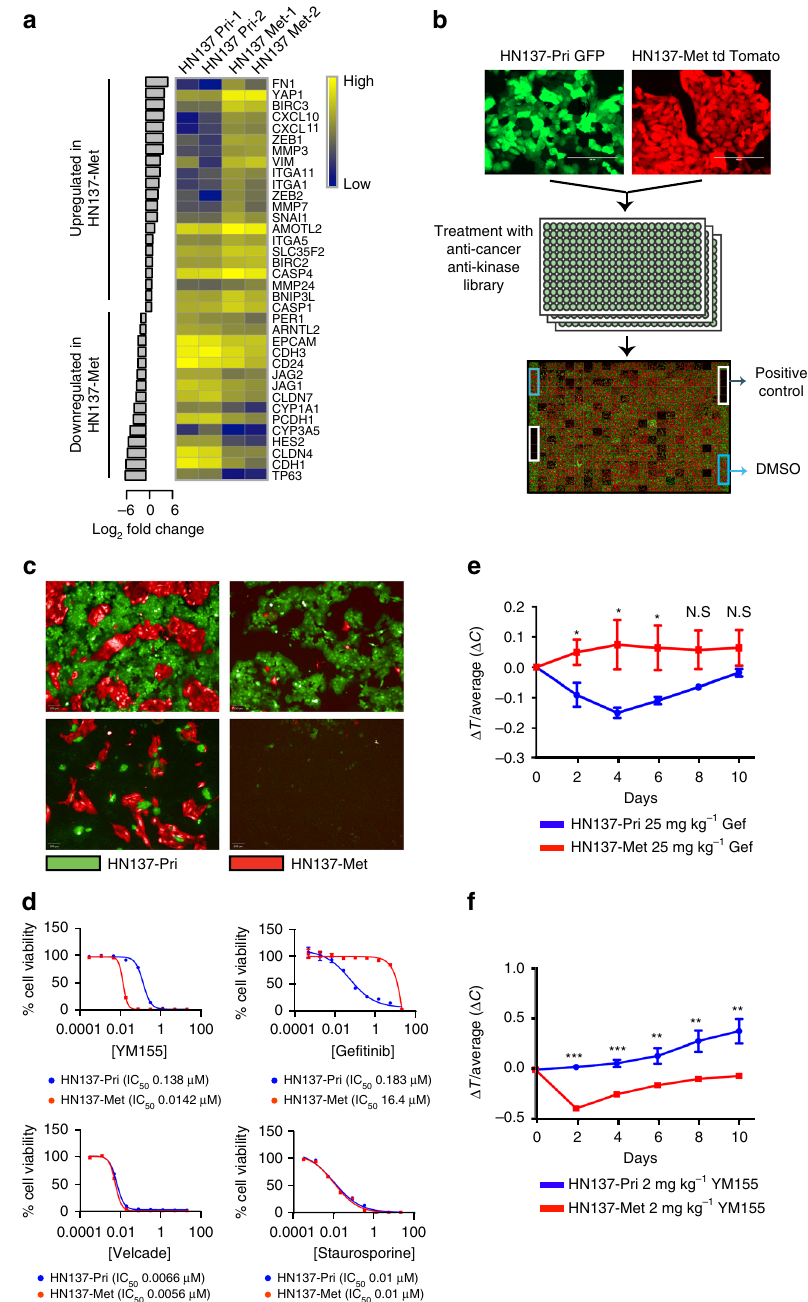
Fig. 2 Small molecule screen against HN137 PDC revealed patient-speci fi c therapeutic vulnerabilities validates in vivo. a Differentially expressed genes (fold-change > 2) in HN137-Met vs. HN137-Pri. The heat map represents (Log 10 ) normalized gene expression data in duplicates. b Schema of the co-culture chemical screen performed in triplicate. c Representative fl uorescence images of cells treated with compounds speci fi cally targeting either HN137-Pri ( bottom left ), HN137-Met ( top right ) or both ( bottom right ). Scale bars , 100 μ m. d Secondary validation of HN137-Met-speci fi c cytotoxic compound (YM155), HN137-Pri-speci fi c cytotoxic compound (ge fi tinib) and dual cytotoxic compounds (Velcade and Staurosporine). Experiments were performed at least twice, in triplicates. Cell viability was determined using CellTiter-Glo reagent. Triplicate data, error bars represent mean ± s.d. e Four independent cohorts of male mice ( n = 5), bearing tumours in both fl anks from HN137-Pri PDX and HN137-Met PDX, were treated with vehicle (control), or 25 mg kg − 1 ge fi tinib (Gef). Note that the HN137-Pri PDX display greater response to ge fi tinib compared to HN137-Met PDX at earlier days (Days 2-6). Error bars represent mean ± s.e.m. Two-tail Student ’ s t test was carried out between HN137-Pri and HN137-Met for days 2-10; N.S.: not signi fi cant, * P < 0.05. f Four independent cohorts of male mice ( n = 5), bearing tumours on both fl anks from HN137-Pri PDX and HN137-Met PDX, were treated with 2 mg kg − 1 of YM155, compared to vehicle (control). A signi fi cant anti-tumour effect was observed for YM155 treatment in HN137-Met PDX while HN137-Pri PDX did not display signi fi cant sensitivity to YM155. Two-tail Student ’ s t test was carried out between HN137-Pri and HN137-Met for days 2-10; * P < 0.05, ** P < 0. 01, *** P < 0.